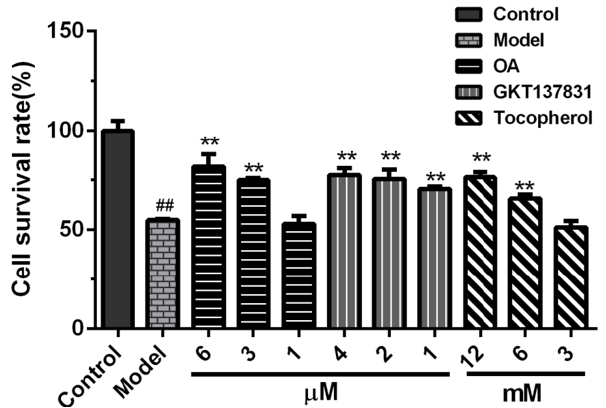
Figure 2. Protective e ff ects of Obcordata A (OA) against calcium oxalate crystals induced HK-2 cell injury. OA and calcium oxalate crystals were simultaneously added to the medium, cultured for 24 h, and cell viability was measured using the MTT assay. All results are expressed as the mean SD of three independent experiments. Cell survival rate in the model group was significantly reduced, and OA, GKT137831, and tocopherol increased cell viability in a dose-dependent manner. ## P < 0.01 versus control group; ** P < 0.01 versus model